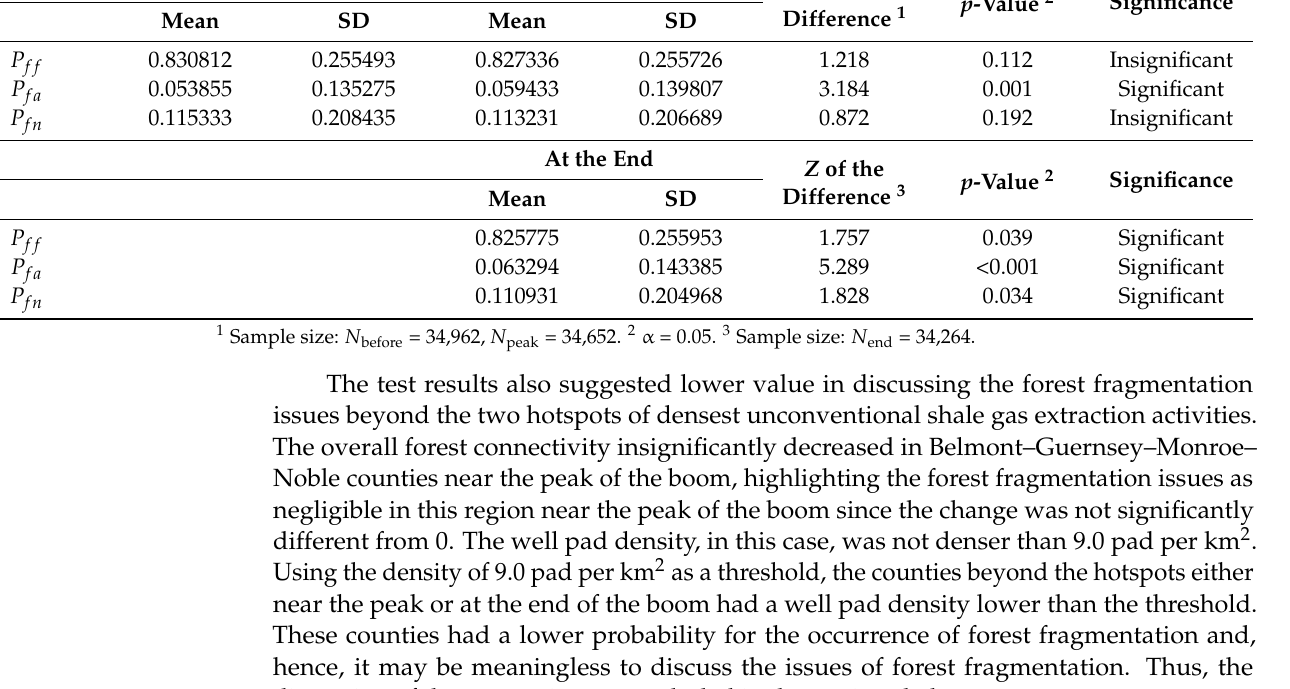
Table 5. The changes in forest fragmentation conditions in Belmont–Guernsey–Monroe–Noble counties. Before the Boom Near tde Peak Z of the Mean SD